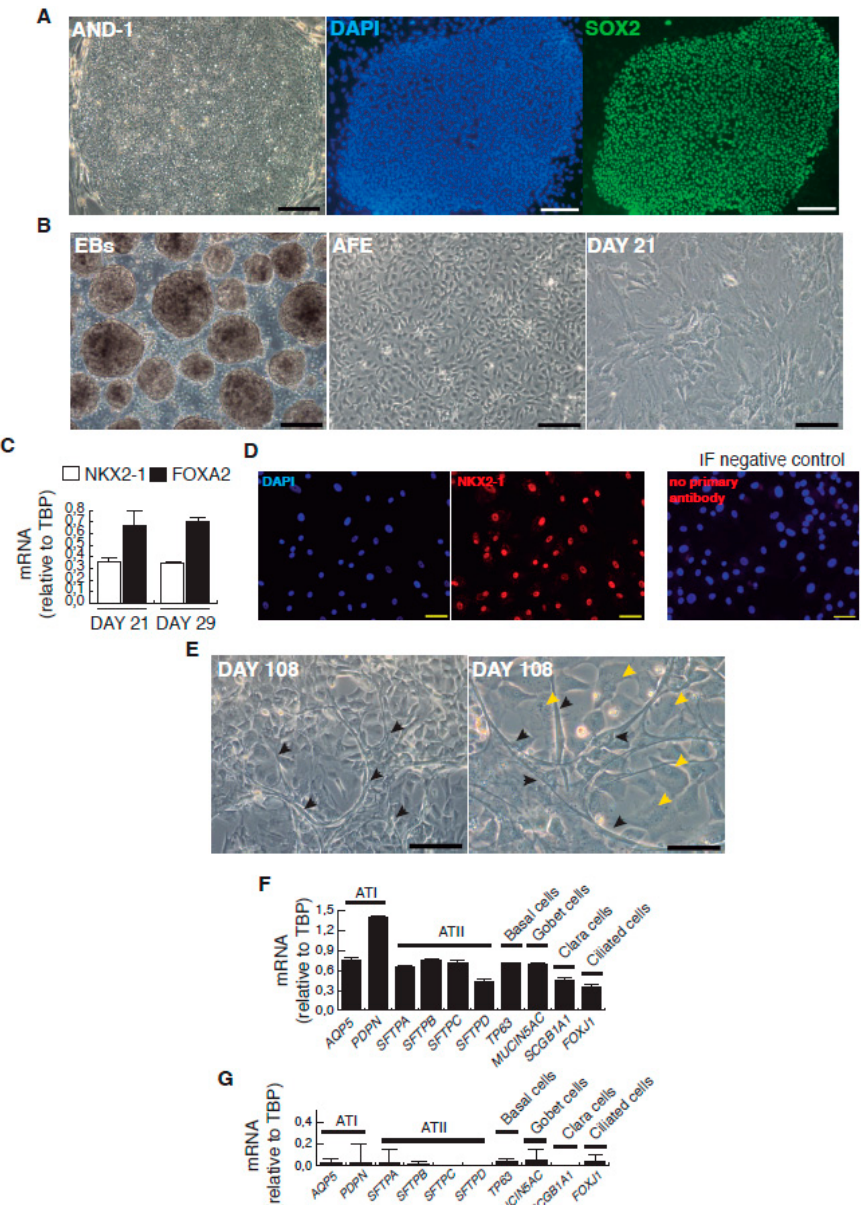
Figure 1. Representative micrographs of the sequential cell differentiation and expression markers. ( A ) AND-1 (ANDalucia-1) colony growing along with feeder cells (left panel; scale bar: 200 μ m); expression of SOX2 (SRY (Sex Determining Region Y)-box 2) in an undifferentiated colony of AND-1 (center and right panels; scale bar: 100 μ m); ( B ) Representative micrographs at different checkpoints. EBs (embryoid bodies), AFE (anterior foregut endoderm) and day 21 of differentiation; scale bar: 100 μ m; ( C ) Levels of expression of NKX2-1 (NK2 Homeobox 1) and FOXA2 (Forkhead Box A2) at days 21 and 29 of differentiation; ( D ) Detection of the expression of NKX2-1 by indirect immunofluorescence at day 29; scale bar: 100 μ m. Immunofluorescence (IF) control: no primary antibody, on the right panel; ( E ) Representative micrographs of the minilung at day 108 of differentiation. Black arrowheads signal cells with a typical flat and crescent shape morphology denoting alveolar type I cells (ATI cells); yellow arrowheads signal cells with ATII morphology. Scale bars: 100 µ m and 50 µ m; ( F ) Levels of expression [relative to TBP (TATA Box Binding Protein)] of lung and airway epithelial cells markers; ( G ) Levels of expression (relative to TBP) of lung and airway epithelial cells markers at an early stage of differentiation (day